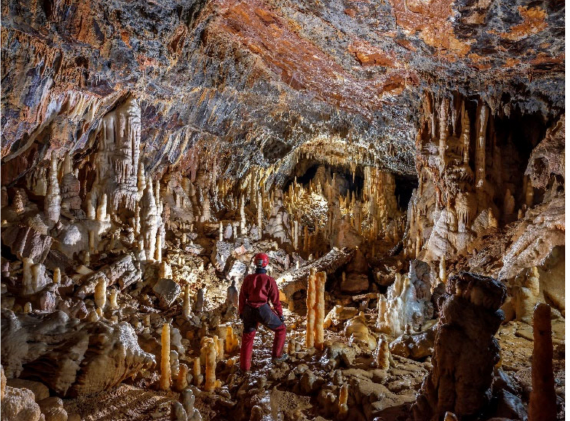
Figure 2. Postojnska jama is a tourist cave, but there are still many beautifully ornamented passages, where only cavers can enter—as the example of “Pisani rov”. Photo: Peter Gedei.